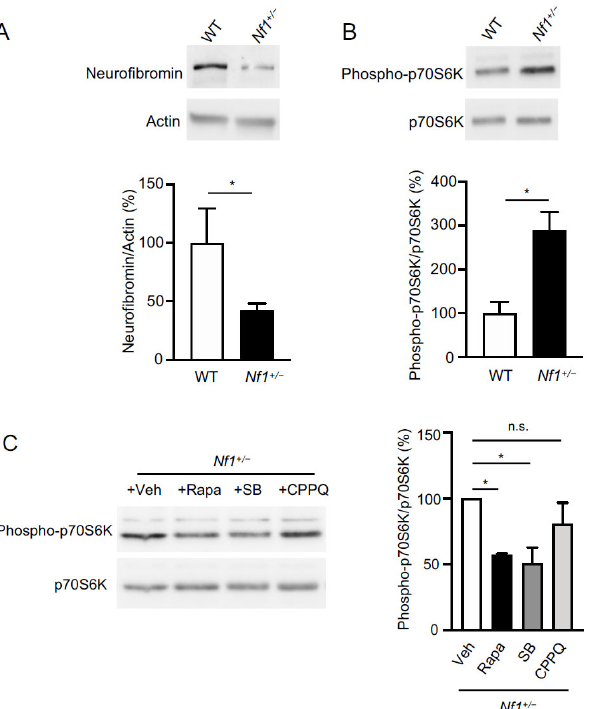
Figure 1. Role of constitutively active 5 ‐ HT 6 receptors in increased mTOR activity in prefrontal cortex of Nf1 +/ − mice. ( A ). Representative Western blot assessing neurofibromin expression in PFC of adult WT and Nf1 +/ − mice. Data represent the ratios of immunoreactive signals of the anti ‐ neurofibromin antibody to the immunoreactive signal of the anti ‐β‐ actin an ‐ tibody and are expressed in % of values in WT mice. ( B ). Representative Western blots assessing p70S6K phosphorylation at Thr 421 ‐ Ser 424 as an index of mTOR activity in PFC of adult WT and Nf1 +/ − mice. Data represent the ratios of immunoreac ‐ tive signals of the anti ‐ phospho ‐ Thr 421 ‐ Ser 424 ‐ p70S6K antibody to the immunoreactive signal of the anti ‐ p70S6K antibody and are expressed in % of values in WT mice. In ( A ) and ( B ), the data illustrated are the mean ± SEM of results obtained in three mice for the WT genotype and five mice for the Nf1 +/ − genotype. * p < 0.05, unpaired t ‐ test. ( C ). Western blots assessing p70S6K phosphorylation at Thr 421 ‐ Ser 424 in PFC of Nf1 +/ − mice injected with either vehicle ( n = 3) or Rapamycin (Rapa, 10 mg/kg, n = 3), or SB258585 (SB, 2.5 mg/kg, n = 3) or CPPQ (2.5 mg/kg, n = 3) 30 min before sacrifice. Data are expressed as in B. * p < 0.05, one ‐ way ANOVA followed by Dunnett’s test. n.s.: not